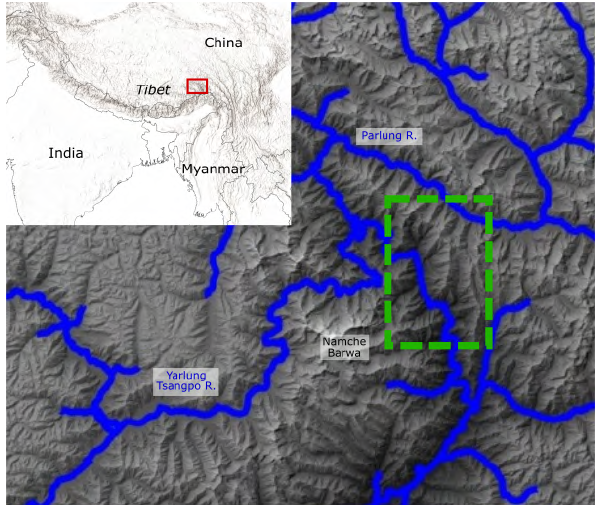
Figure 6. Namche Barwa–Gyala Peri massif used for model eval- uation. The red rectangle on the inset figure indicates the loca- tion of the study area. The green dashed rectangle indicates the part of the DEM used to evaluate HyLands. The shaded colors show elevation derived from the 30m SRTM v3 DEM (Farr et al., 2007) and resampled to a higher resolution of 20m using a bicu- bic interpolation method. Main map is produced with TopoTool- box (Schwanghart and Scherler, 2014). Inset map is made in QGIS 3.10.9, using Natural Earth vector and raster map data available at http://www.naturalearthdata.com (last access: 25 August